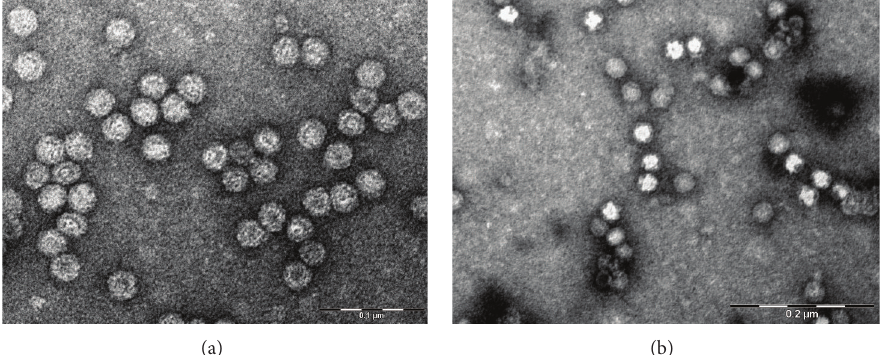
Figure 2: Electron micrograph of recombinant PPV VP2 VLPs in CsCl fraction ((a), scale bar = 100nm) and VLPs resolubilized after lyophilisation ((b), scale bar = 200